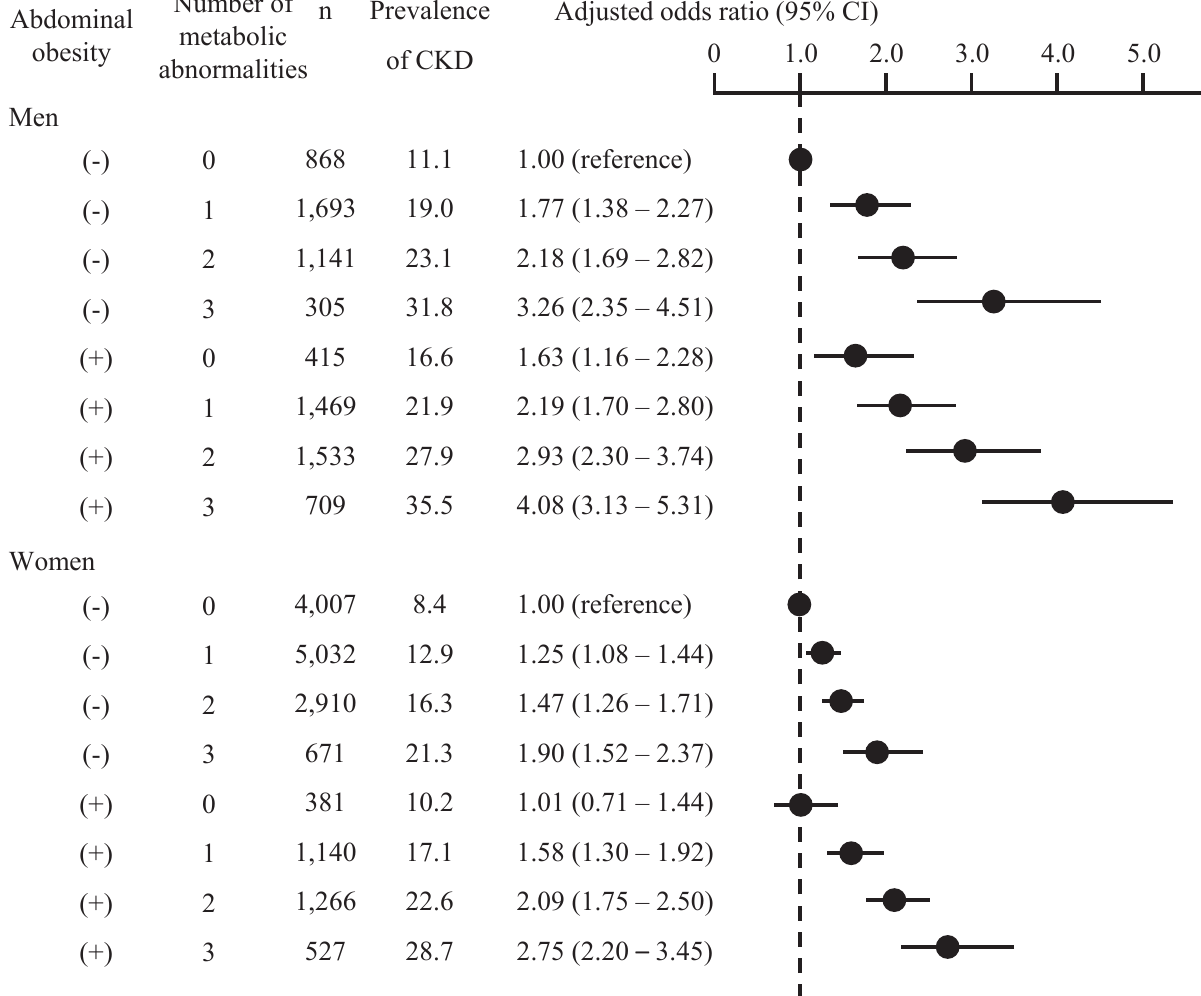
Figure 1. Prevalence of abdominal obesity, number of complicated metabolic abnormalities, and the odds ratio of chronic kidney disease in Japanese men and women. Odds ratios were adjusted for age, smoking status, and alcohol consumption. CI, con fi dence interval; CKD, chronic kidney